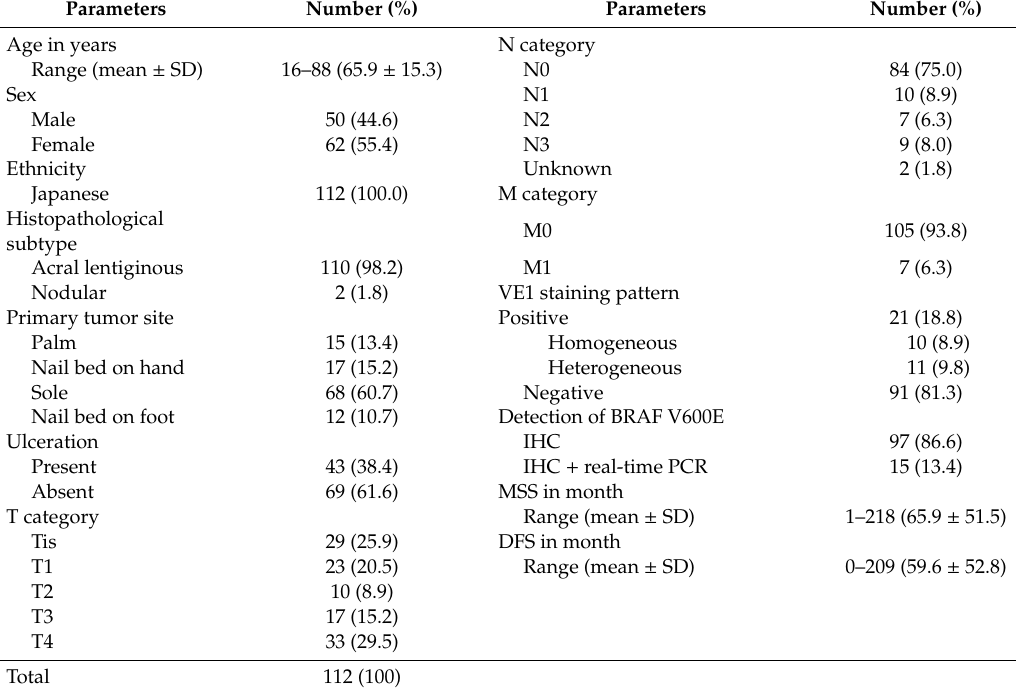
Table 1. Clinicopathological data of all acral melanoma